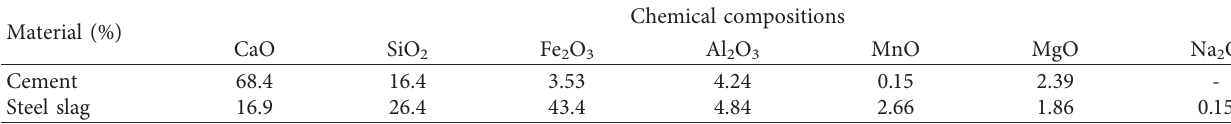
Table 2: Chemical composition of cement and steel slag